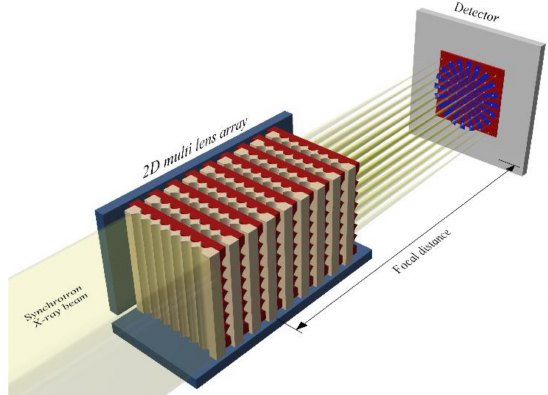
Figure 1. Principle of 2D X-ray multi-contrast imaging with the sample positioned in front of the detector for absorption contrast imaging. Illuminated by the X-ray beam, the 2D multi-lens array generates an array of point foci. The sample is placed in the focal plane. At each sample position, the intensity variations are recorded by a low resolution (LR) detector, which is placed as near as possible behind the sample. The physical aperture of the individual lenslets of the array matches the pixel size. Each focal point hits its corresponding pixel in the center. Sub-pixel resolution scanning transmission X-ray microscopy is achieved by raster-scanning the sample with sub-pixel sized steps through the point